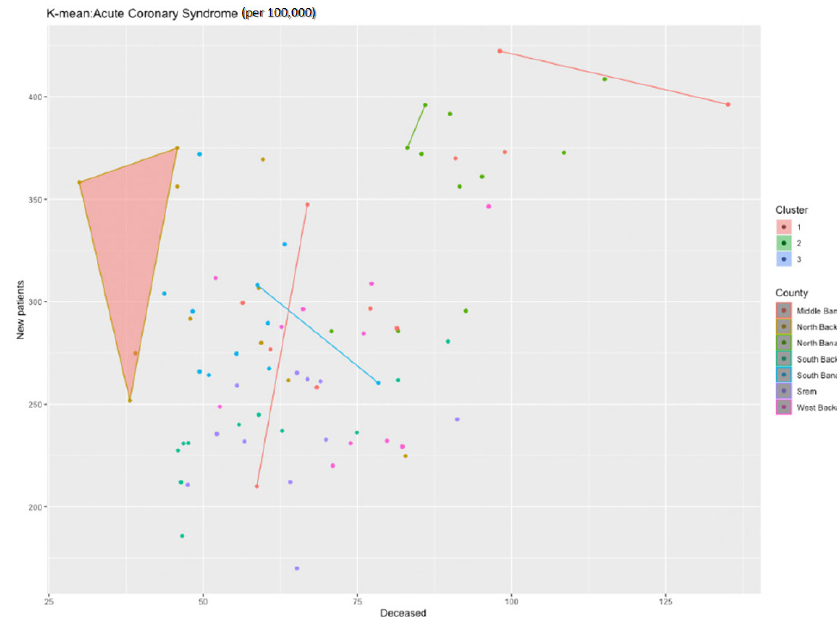
Figure 4. Identification of clusters during the analysis of acute coronary syndrome in the researched area.